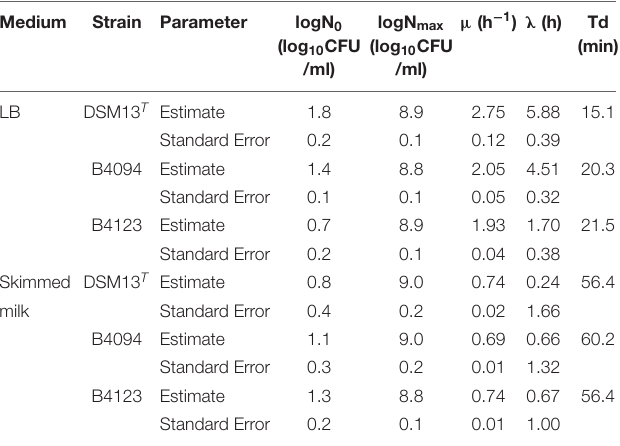
TABLE 2 | Estimated growth rate mu ( µ ) and lag time ( λ ) for DSM13 T , B4094, and B4123 in LB and skimmed milk using the Baranyi primary growth model. Medium Strain